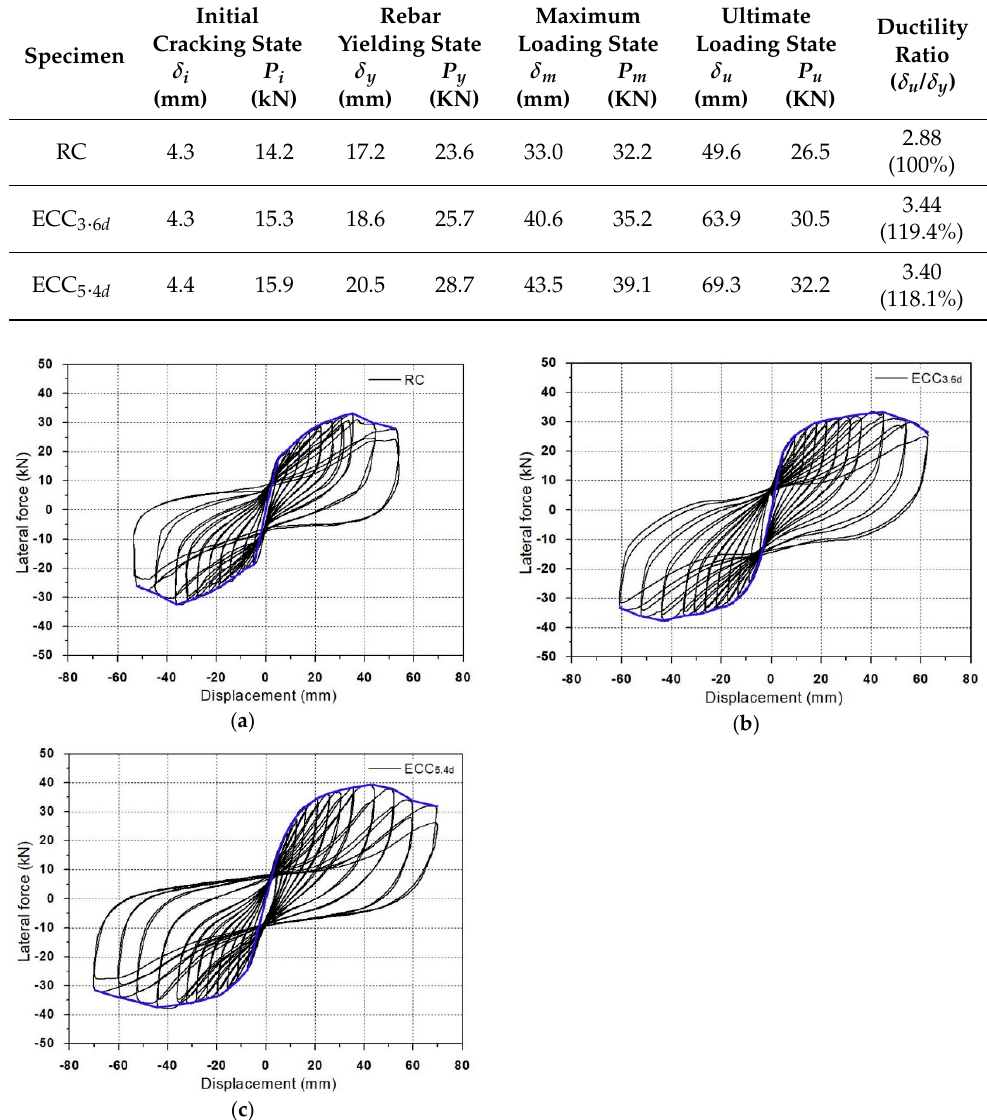
Figure 8. Relationship curves of lateral load–displacement hysteretic behavior ( a ) RC ( b ) ECC 3 . 6 d ( c ) ECC 5 . 4 d . ( c ) ECC 5 . 4 d Table 5. Result of repeated loading test under the positive force condition.